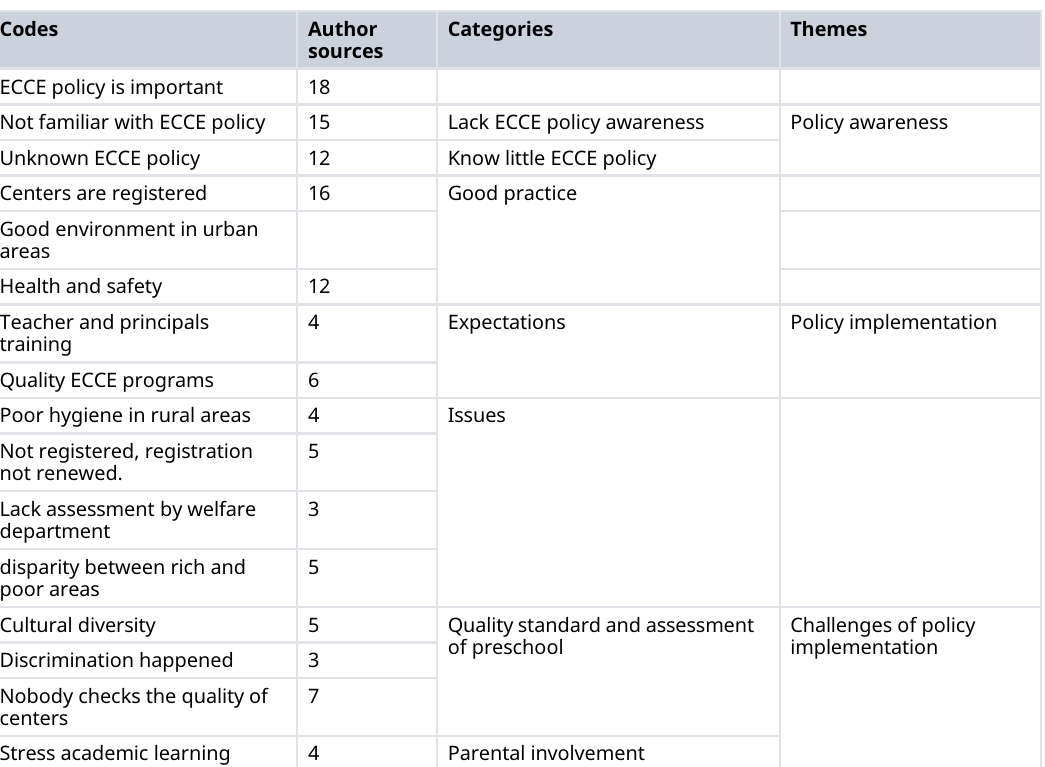
Table 5. Three themes regarding parents ’ perceptions on ECCE